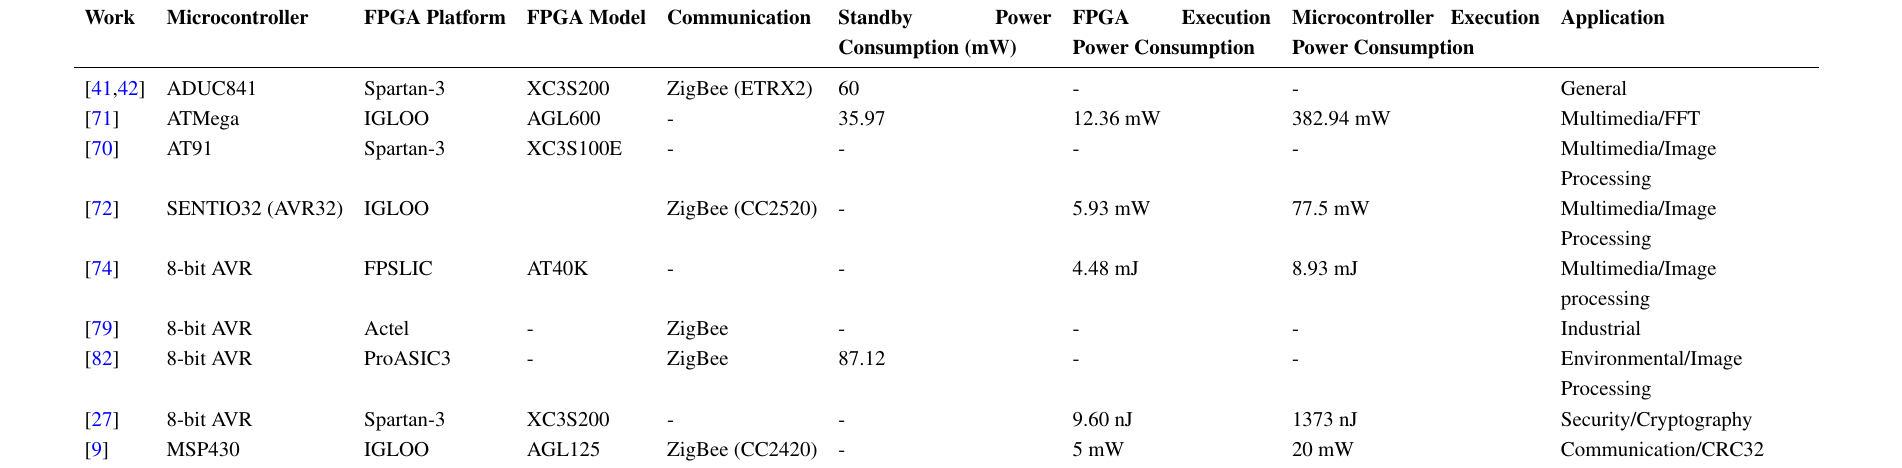
Table 7. Sensor nodes based on a combination of microcontroller and FPGA